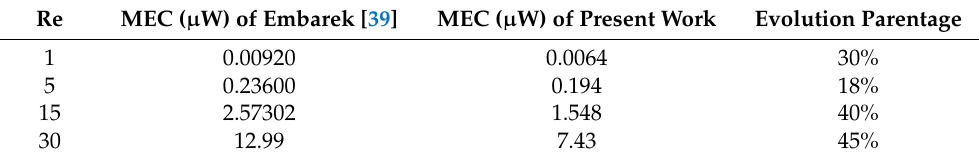
Table 5. Quantitative comparison of the Energy Mixing Cost for varied generalized Reynolds number (Re = 1, 5, 15 and 15) with that obtained by Embarek et al. reprinted with permission from [41] in 2021y.